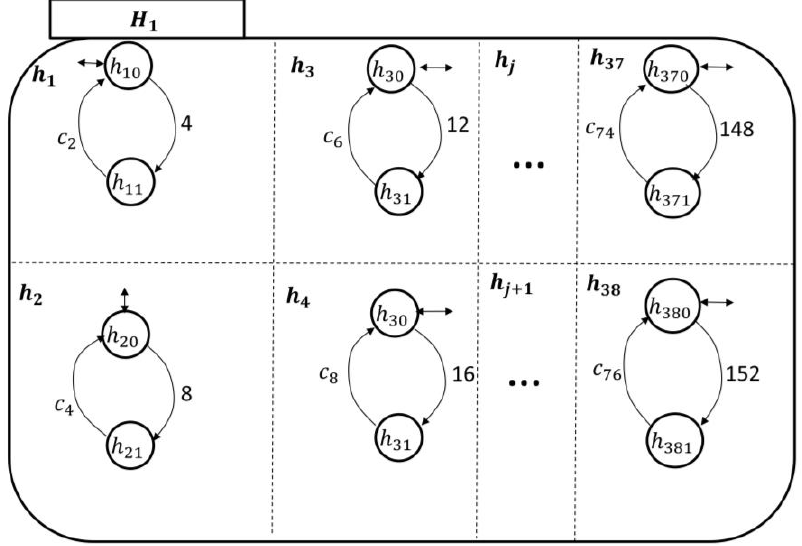
Figure 11. The hospitalist automaton transitional model.